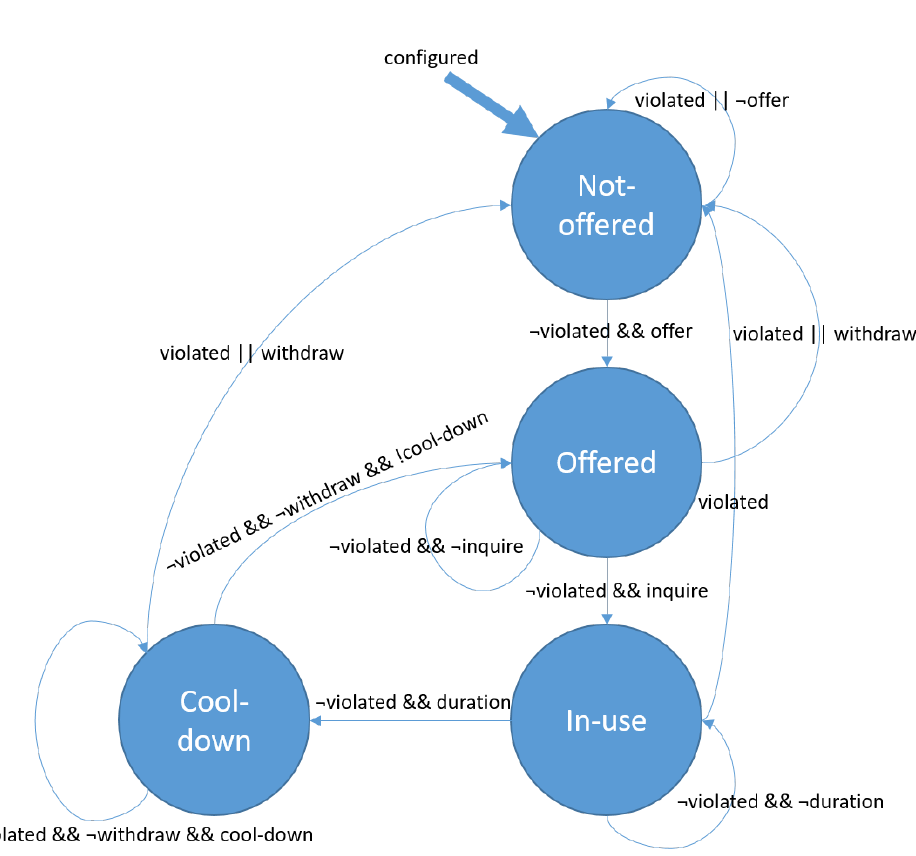
Figure 4. The different state transitions of a flexibility. The events that can lead to changes of states are configured , offer , violated , withdraw , inquire , duration , and cool-down . Combinations of these events, or their absence (indicated by their negation “ ¬ ”), allow flexibilities to transition between the different